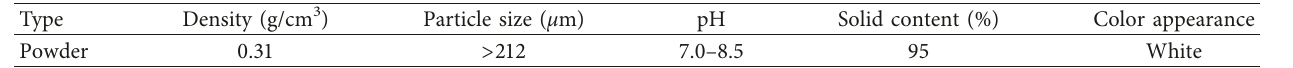
Table 2: Properties of retardant.